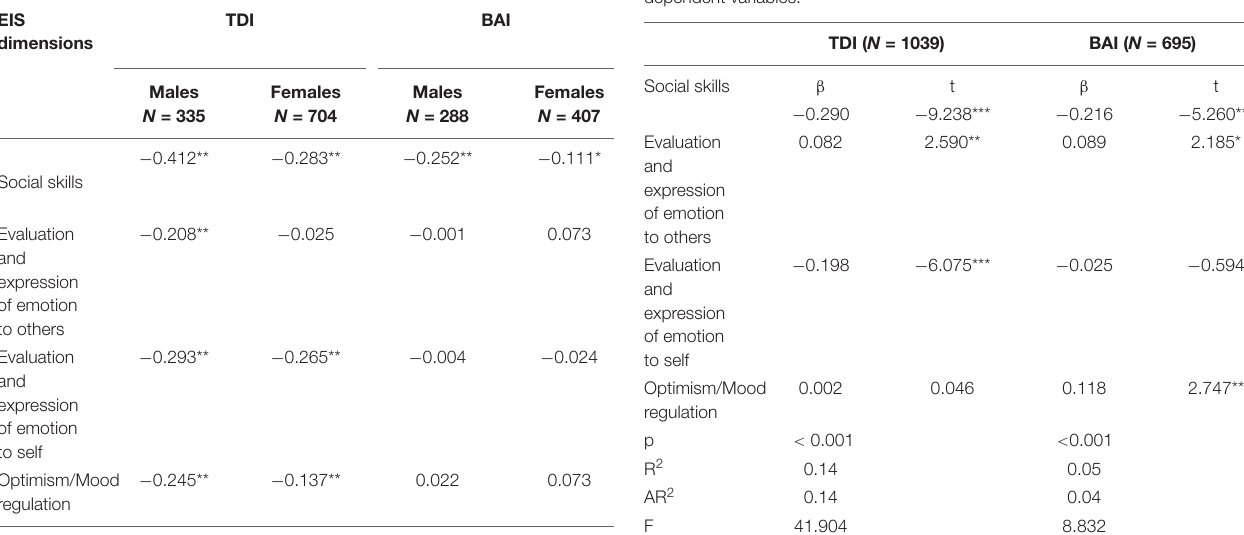
TABLE 5 | Correlations between EIS dimensions, TDI and BAI, divided for gender. TABLE 6 | Regression analysis of EIS dimensions with anxiety and depression as dependent